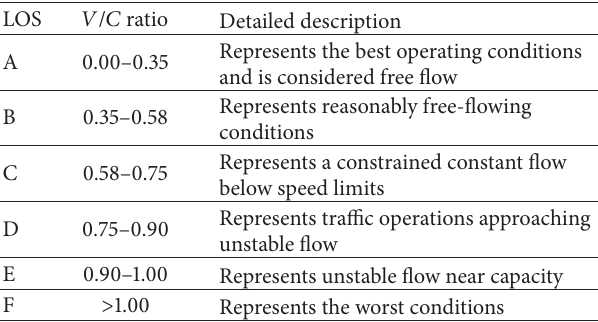
Table 1: Levels of service (LOS) [25,